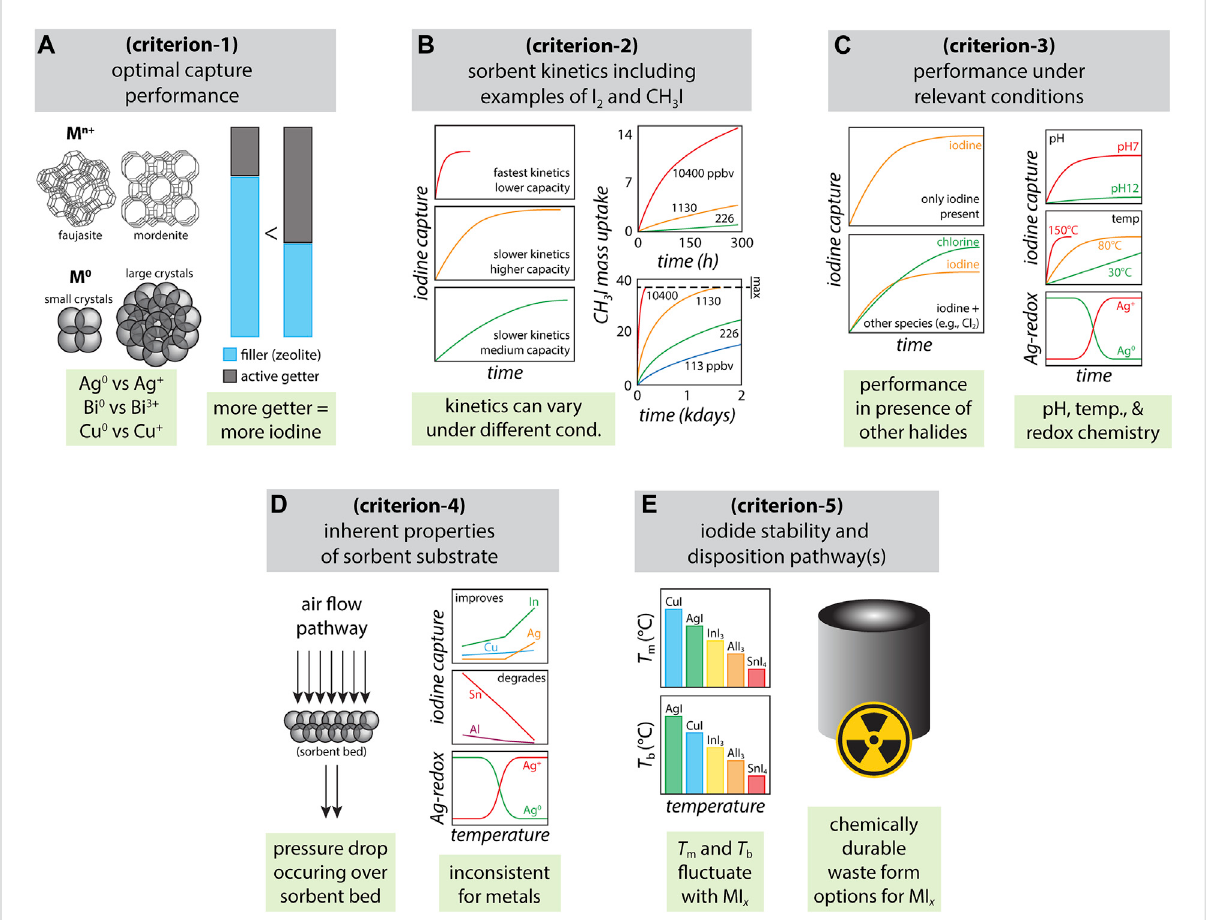
FIGURE 1 Summary ofvariousparameters forconsiderationwhenselectingsorbentsforradioiodine: (A) optimalcaptureperformanceincludingdifferent types of Ag-zeolites that have different Ag loadings (Riley et al., 2022b) (criterion-1), (B) sorbent kinetics including examples based off actual data for